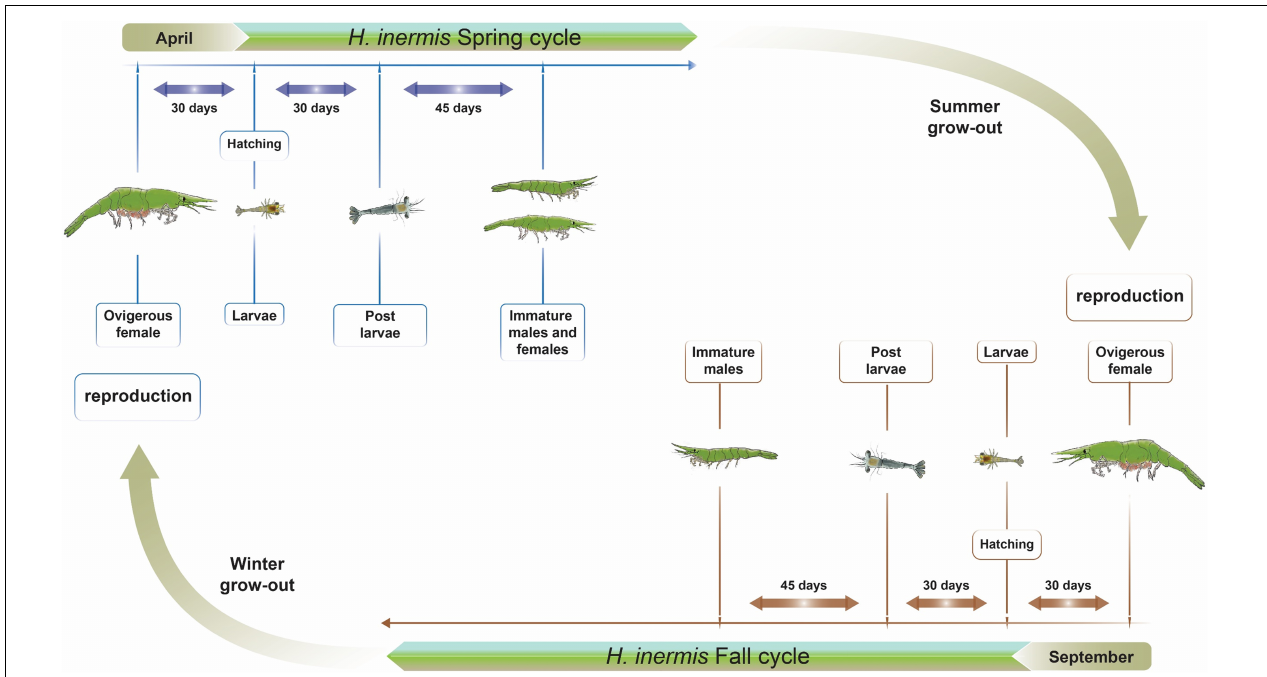
FIGURE 1 | Two reproductive cycles in the life cycle of Hippolyte inermis . Two reproductive seasons are shown. Animals that hatch in April, due to a higher abundance of Cocconeis spp. diatoms, become either immature males or females by July and, following a summer grow-out, reproduce in September. Animals that hatch in September, due to a lower abundance of the diatoms, become males by December and, following a winter grow-out, reproduce in